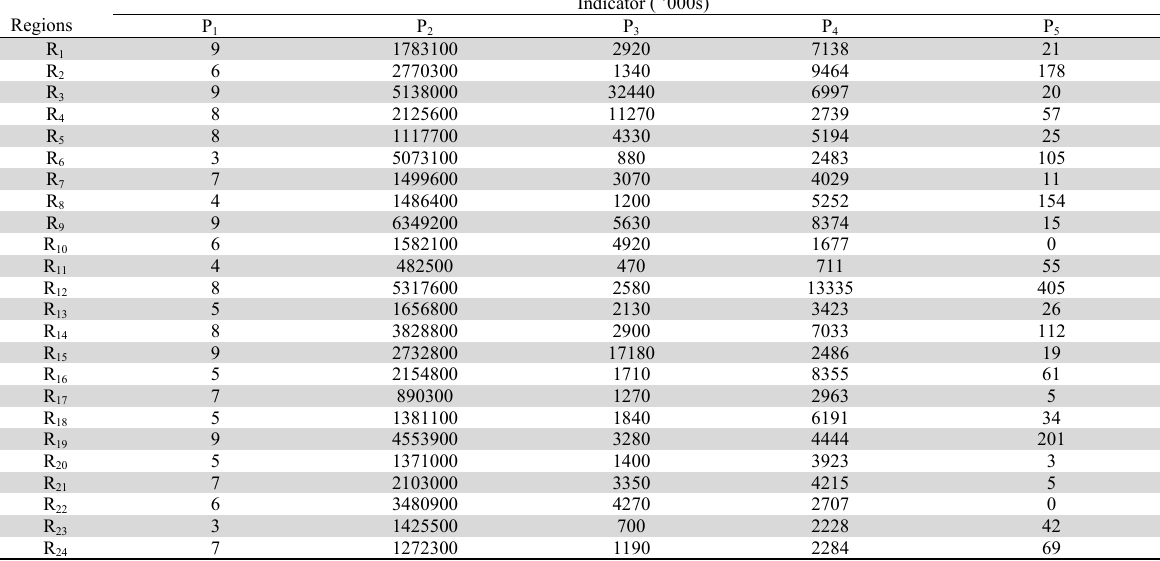
Table 3 The summary of input/output indicators